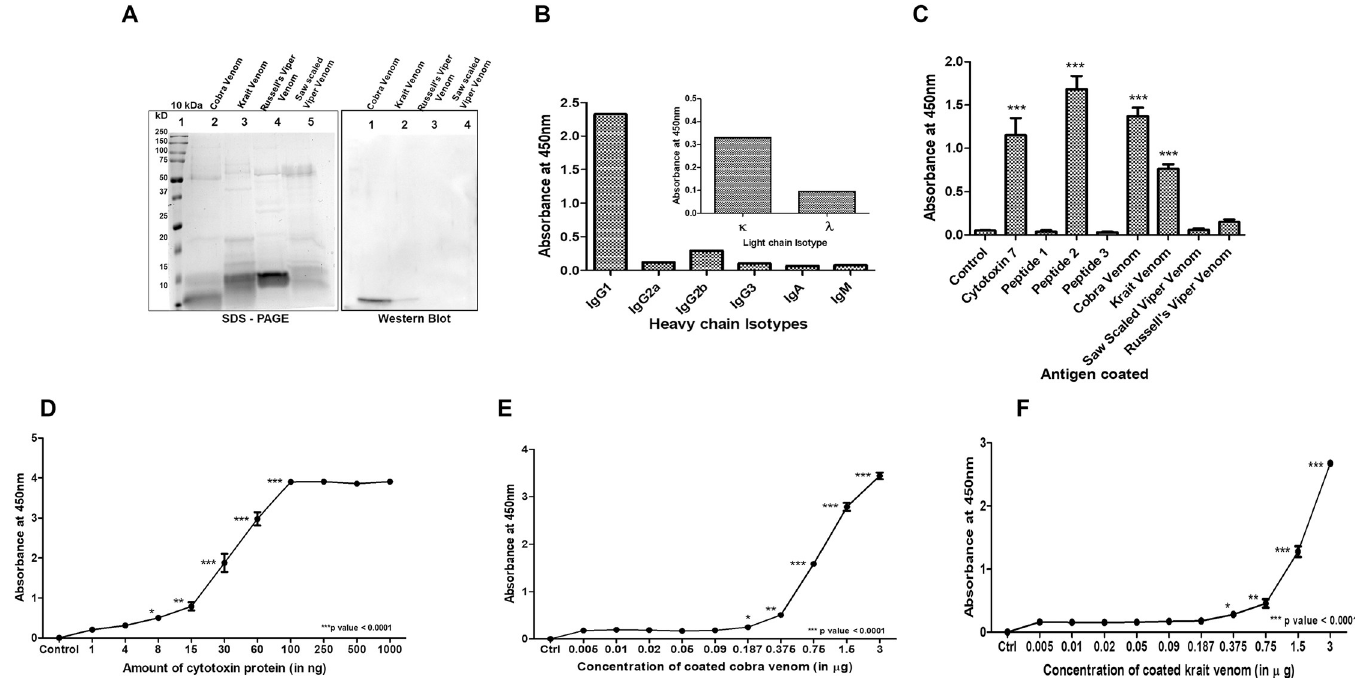
Fig 2. Characterization of monoclonal antibody. Panel A . Equal amount of venoms of big four snakes was electrophoretically separated on two gels. The Coomassie- stained gel shows the electrophoretic profile of each venom protein (5 μ g) whereas the Western blot performed using monoclonal antibody shows the immunoreactivity of AB1 towards cytotoxin– 7 in respective venom samples (0.5 μ g). Panel B . Quantitative representation of the ELISA based Isotyping of the heavy and light chain fragments of the purified antibody (AB1). Panel C . The graph depicts the reactivity of different antigens with AB1 monoclonal antibody. The data shows the Mean ± SE of 3 different experiments (in duplicates). The y—axis shows the absorbance values obtained for each antigen after normalization with the values obtained for uncoated control. Panel D , E , and F . Varying concentrations of rCTX-7, cobra, and krait venom were tested to determine the sensitivity of its detection by AB1 through indirect ELISA. The y–axis shows the mean absorbance ± SE of three different experiments performed in duplicates after normalization with the values obtained for uncoated wells. The statistical significance of each sample was calculated with respect to control, unless otherwise indicated in the figure ( ��� p < 0.0001).